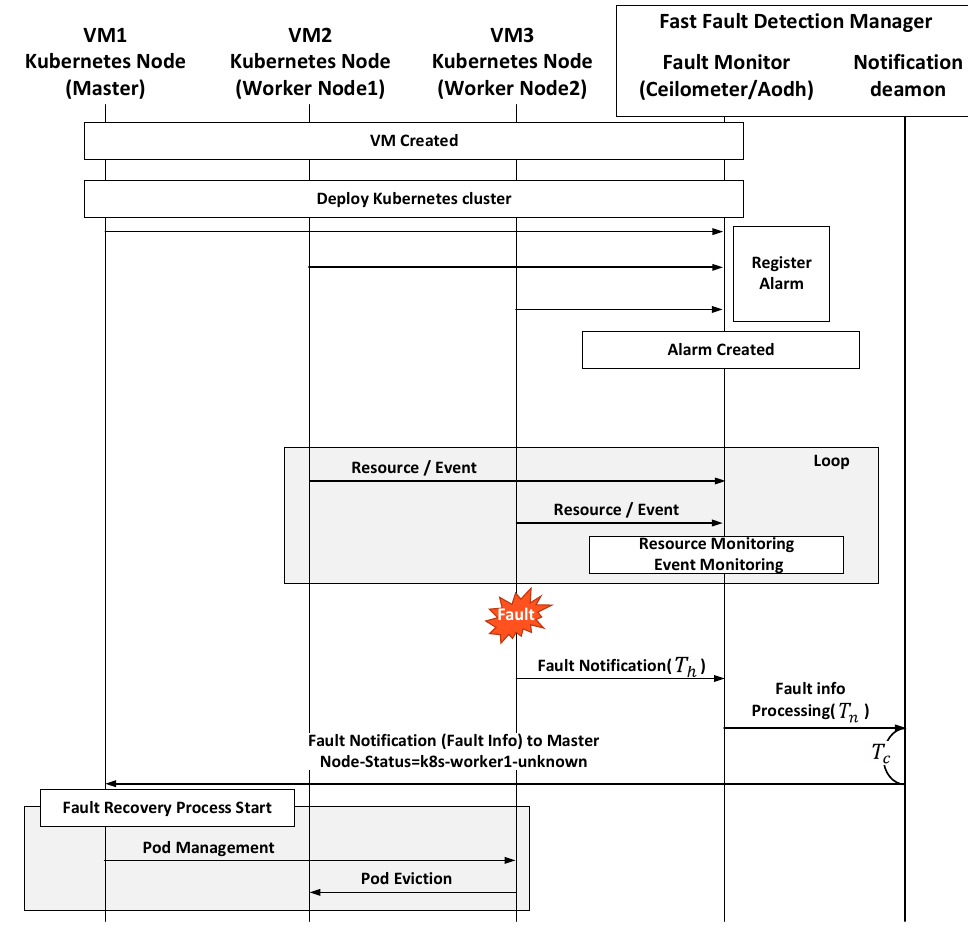
Figure 4. Fault detection and recovery procedures in the proposed architecture.